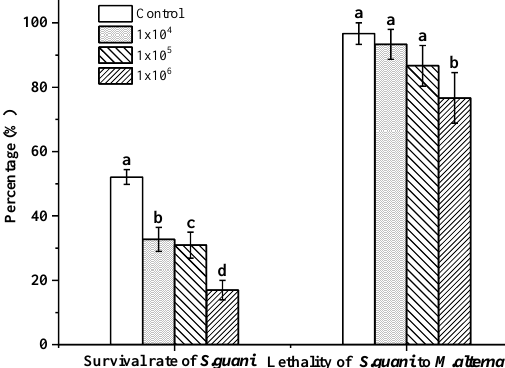
Figure 3. The survival rate of S. guani and lethality of S. guani to M. alternatus at different concentrations of B. bassiana spore suspension. Different letters above the bars indicate significant differences (mean ± SE, n = 30 in each treatment, p < 0.05).